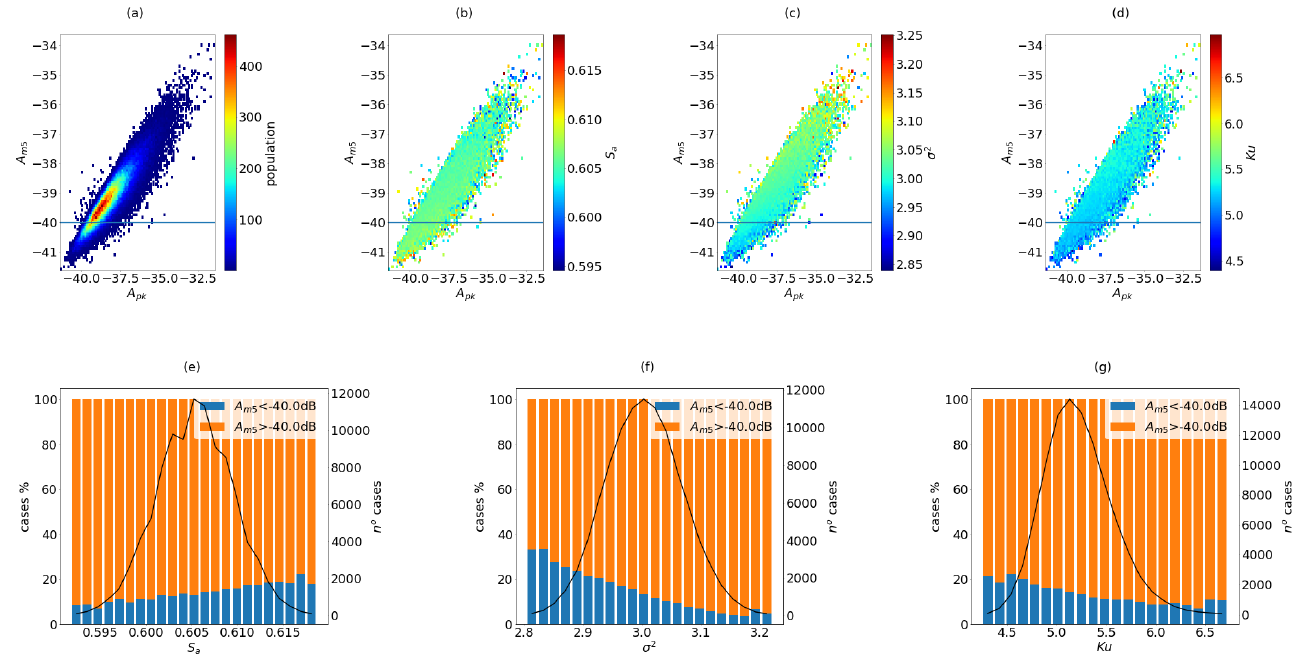
Figure 6. Results of 100,000 random cases of configuration 100V. In the first row, the apertures are presented in A m 5 vs. A pk map, ( a ) population, ( b ) S a , ( c ) σ 2 and ( d ) Ku . In the second row, the distribution of cases against the coarray parameters are presented, marking the proportion of case that fulfill the TH A threshold, ( e ) S a , ( f ) σ 2 and ( g ) Ku m 5